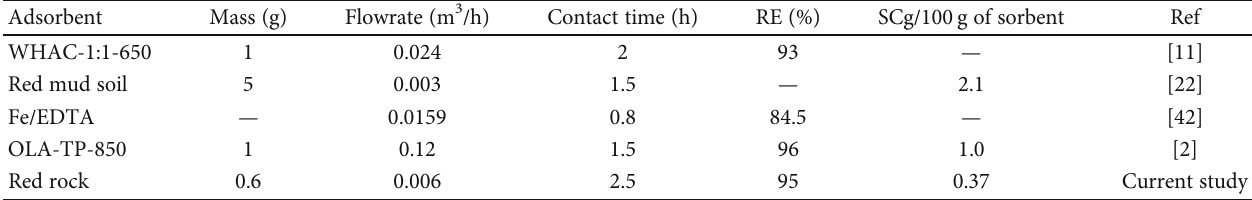
Figure 9: Adsorption performance comparison between original and regenerated samples. (a) H = 1000 ° C , FR = 0 : 006m 3 /h , particlesize = 0 : 32 ‐ 250 μ m , and C SC. Test conditions: m = 0 : 6 g , T c Table 4: Evaluation of RR adsorbent with other materials reported in the